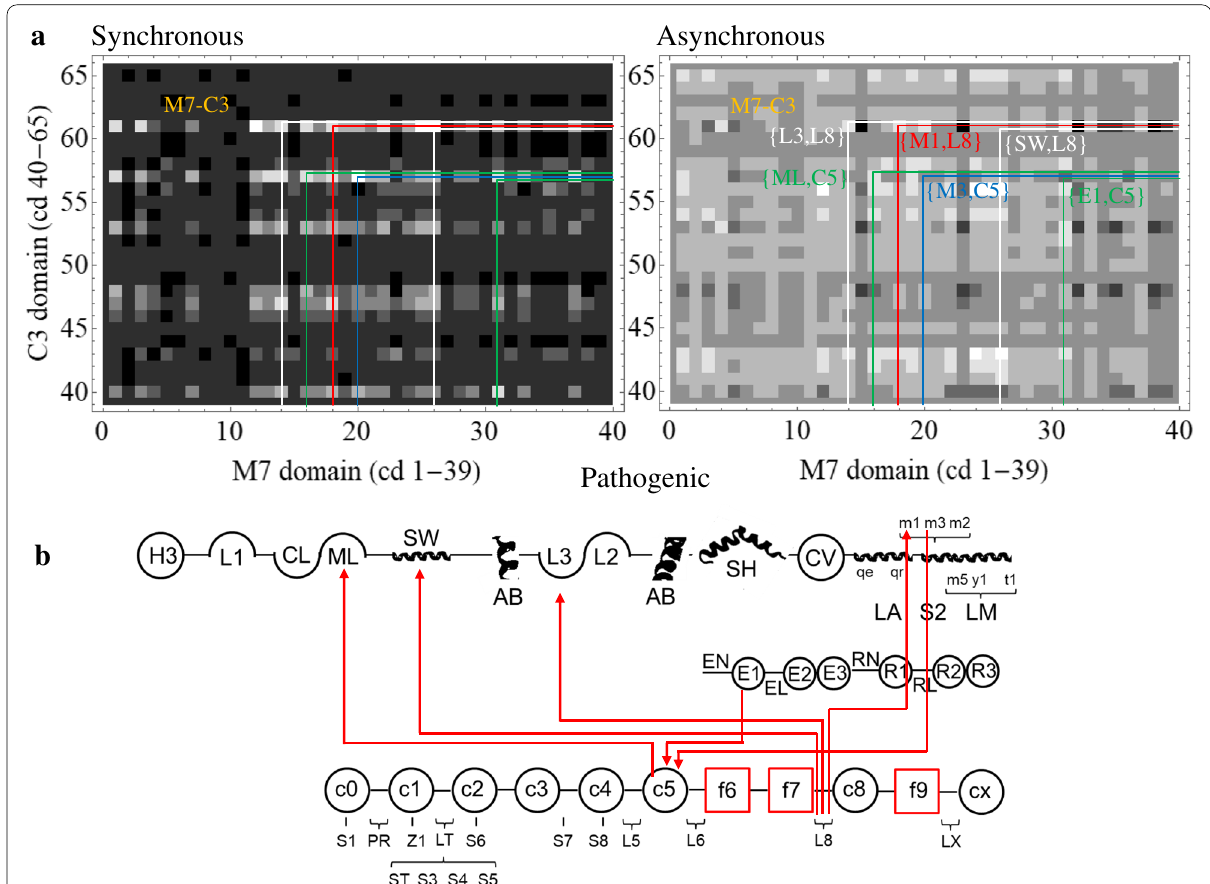
Fig. 5 βmys/MYBPC3 complex cross-correlation maps and their implied inter-protein domain linkages for pathogenic outcomes. a M7-C3 region for synchronous and asynchronous maps and the portion of the correlation squares falling within them for pathogenic outcomes taken from Fig. 4. Co-domain ordered pairs corresponding to each correlation square are indicated in parenthesis for M7 domain and C3 domain in first and second positions, respectively. Ordered pairs are color coded to match the corresponding correlation square. b Red lines show most significant directed co-domain interactions between βmys and MYBPC3 for pathogenic outcomes. Nomenclature otherwise identical to Fig.